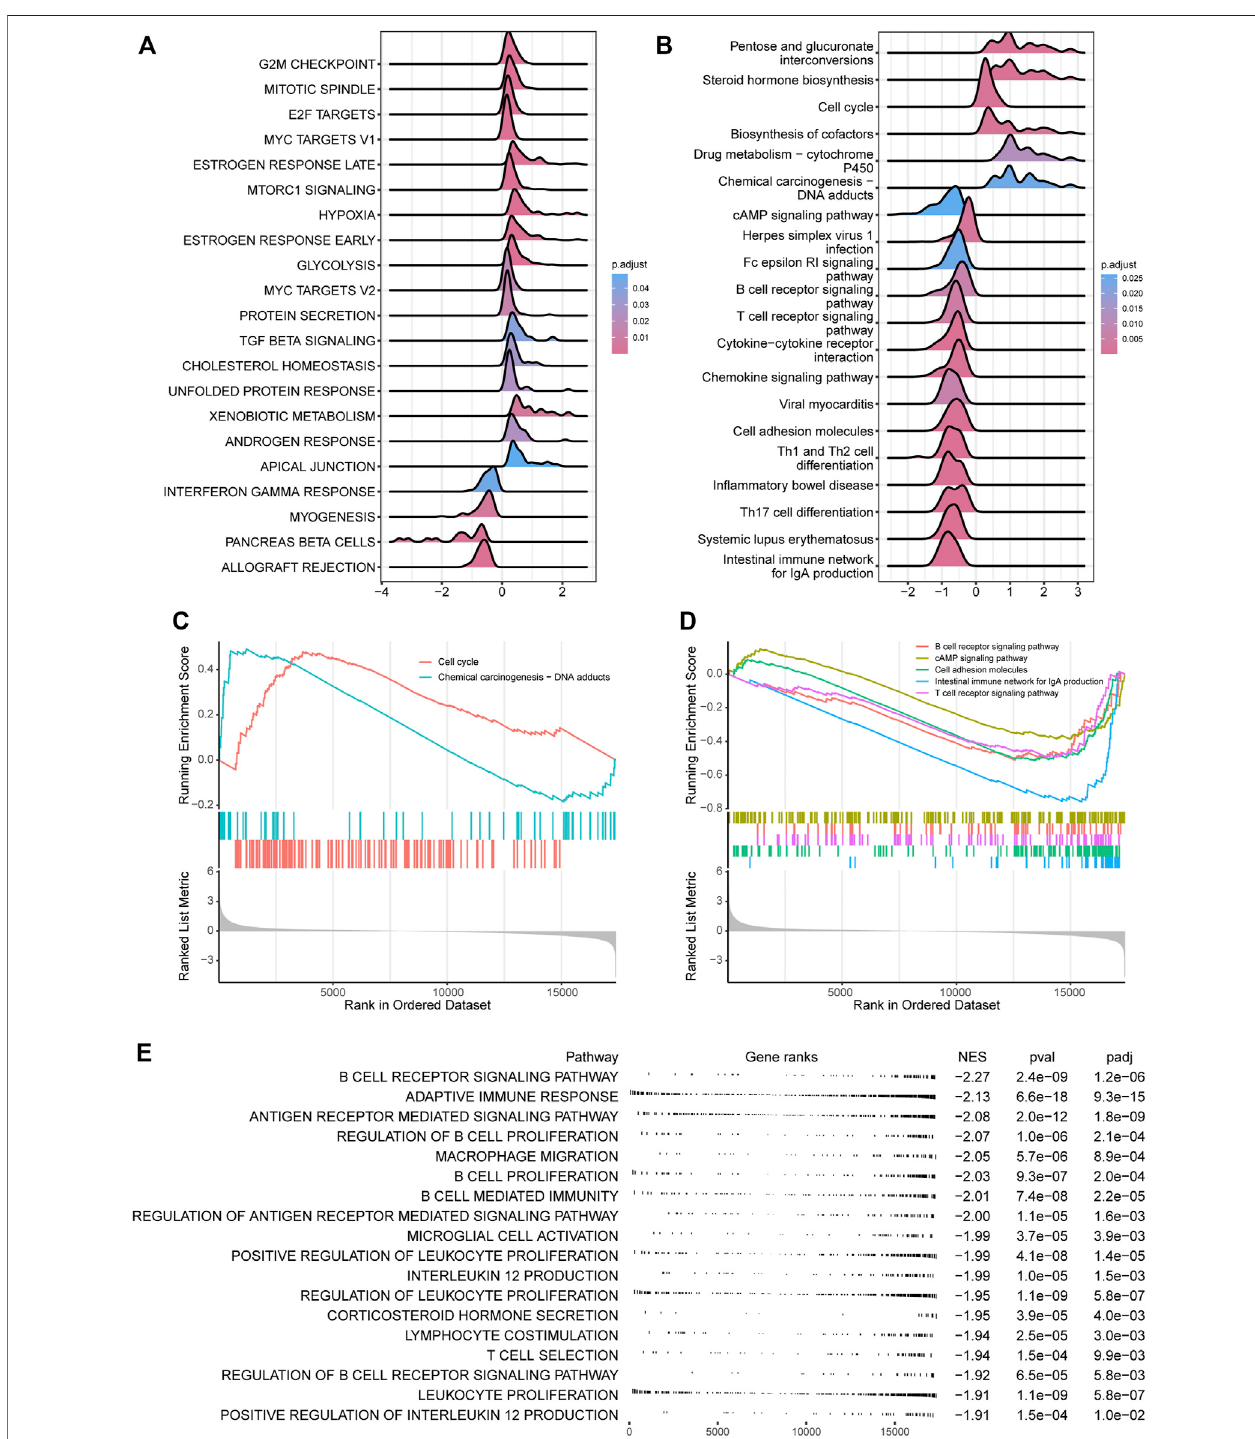
FIGURE6| CRDCrelevantfunctionalanalysis.Ridgelineplotsforlog2FC(CRDC-HighversusCRDC-Low)distributionofcore-enrichedgenesin (A) hallmarksand (B) KEGG pathways based on the GSEA method. GSEA plots for (C) positive and (D) negative KEGG pathways associated with CRDC. (E) Table of the CRDC-related negative GO (BP) enrichment